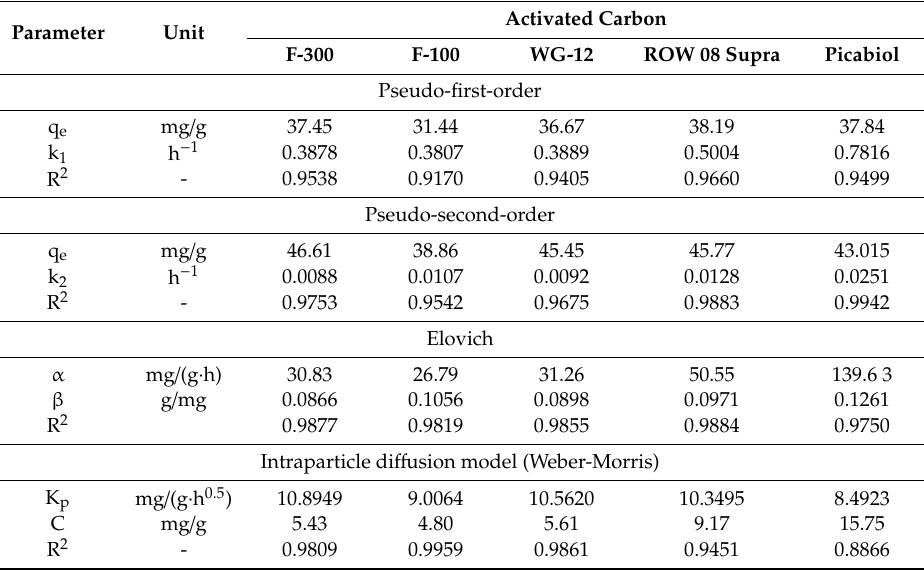
Figure 2. Kinetics of adsorption of chloramphenicol on commercial activated carbons. Table 5. Constants for the kinetics equations: pseudo first-order, pseudo second-order, intraparticle di ff usion model (Weber–Morris) and